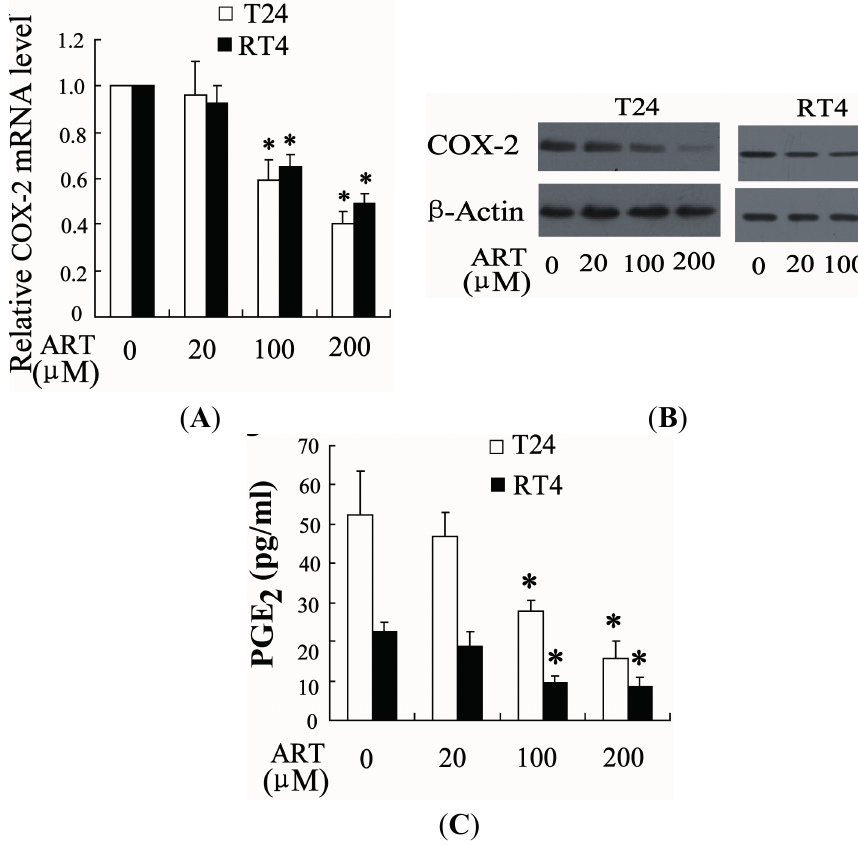
Figure 5. ART decreases COX-2 expression and prostaglandin E2 (PGE2) production in bladder cancer cells. T24 and RT4 cells were treated with different concentrations of ART, followed by real-time PCR ( A ) and Western blot analysis ( B ); The concentrations of PGE2 were detected in the supernatants of T24 and RT4 cells treated with different concentration of ART ( C ). * p < 0.05, compared to